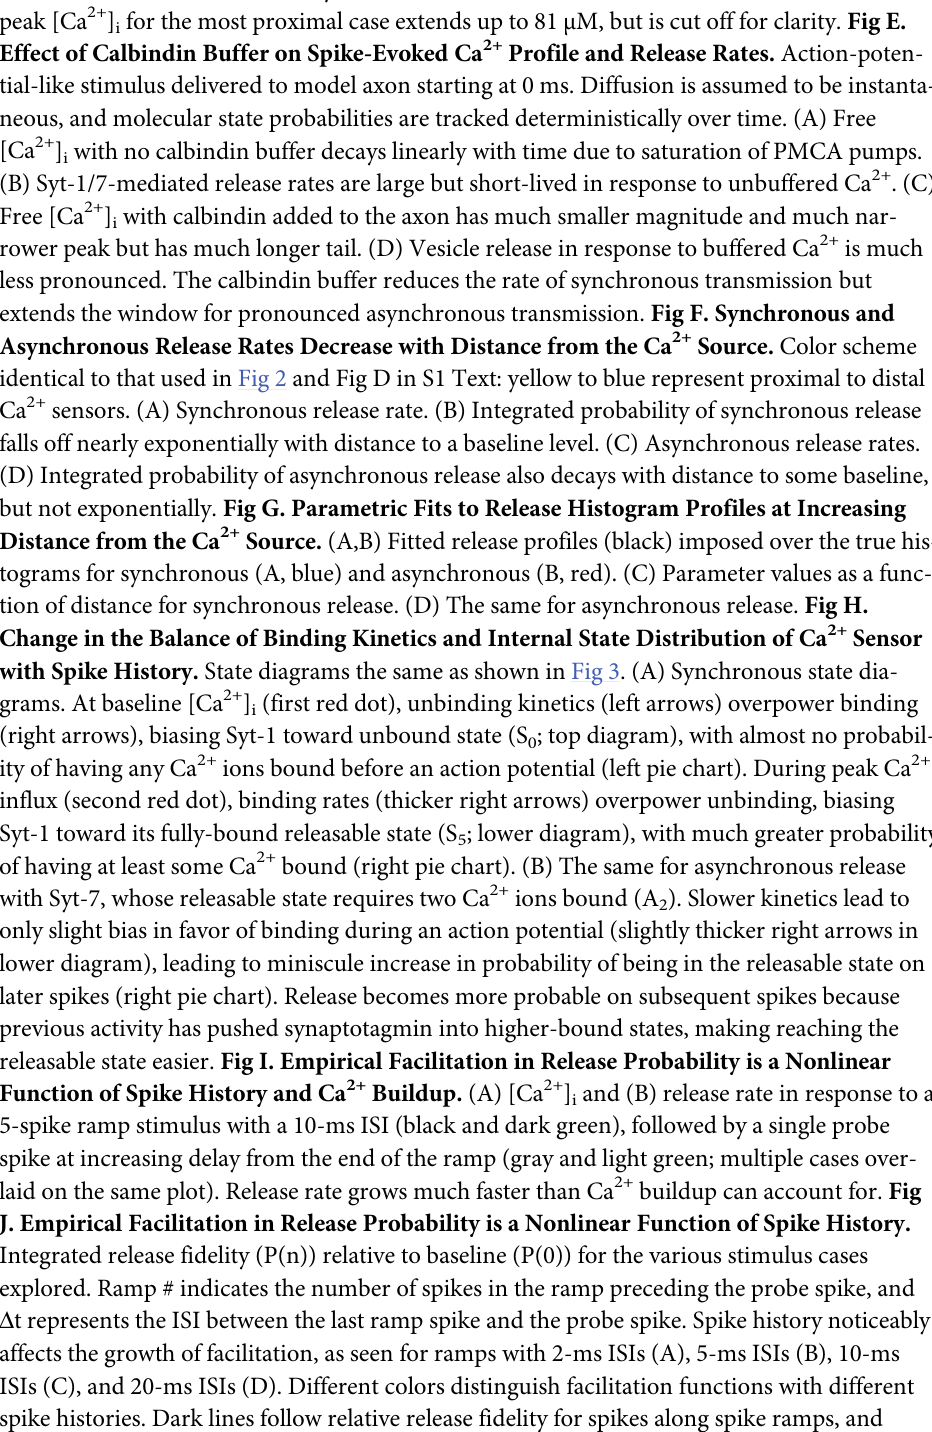
that used in Fig 2: yellow to blue represent proximal to distal Ca 2+ sensors. (A) [Ca 2+ ] mea- i sured at increasing distance from VDCC source (yellow to blue), with well-mixed approxima- tion overlaid for comparison (maroon). Inset focuses on shorter time scale. (B) Profiles with calbindin removed from MCell (yellow to blue) and well-mixed model (maroon). Note that peak [Ca 2+ ] for the most proximal case extends up to 81 μ M, but is cut off for clarity. Fig E. i Effect of Calbindin Buffer on Spike-Evoked Ca 2+ Profile and Release Rates. Action-poten- tial-like stimulus delivered to model axon starting at 0 ms. Diffusion is assumed to be instanta- neous, and molecular state probabilities are tracked deterministically over time. (A) Free [Ca 2+ ] with no calbindin buffer decays linearly with time due to saturation of PMCA pumps. i (B) Syt-1/7-mediated release rates are large but short-lived in response to unbuffered Ca 2+ . (C) Free [Ca 2+ ] with calbindin added to the axon has much smaller magnitude and much nar- i rower peak but has much longer tail. (D) Vesicle release in response to buffered Ca 2+ is much less pronounced. The calbindin buffer reduces the rate of synchronous transmission but extends the window for pronounced asynchronous transmission. Fig F. Synchronous and Asynchronous Release Rates Decrease with Distance from the Ca 2+ Source. Color scheme identical to that used in Fig 2 and Fig D in S1 Text: yellow to blue represent proximal to distal Ca 2+ sensors. (A) Synchronous release rate. (B) Integrated probability of synchronous release falls off nearly exponentially with distance to a baseline level. (C) Asynchronous release rates. (D) Integrated probability of asynchronous release also decays with distance to some baseline, but not exponentially. Fig G. Parametric Fits to Release Histogram Profiles at Increasing Distance from the Ca 2+ Source. (A,B) Fitted release profiles (black) imposed over the true his- tograms for synchronous (A, blue) and asynchronous (B, red). (C) Parameter values as a func- tion of distance for synchronous release. (D) The same for asynchronous release. Fig H. Change in the Balance of Binding Kinetics and Internal State Distribution of Ca 2+ Sensor with Spike History. State diagrams the same as shown in Fig 3. (A) Synchronous state dia- grams. At baseline [Ca 2+ ] (first red dot), unbinding kinetics (left arrows) overpower binding i (right arrows), biasing Syt-1 toward unbound state (S ; top diagram), with almost no probabil- 0 ity of having any Ca 2+ ions bound before an action potential (left pie chart). During peak Ca 2+ influx (second red dot), binding rates (thicker right arrows) overpower unbinding, biasing Syt-1 toward its fully-bound releasable state (S ; lower diagram), with much greater probability 5 of having at least some Ca 2+ bound (right pie chart). (B) The same for asynchronous release with Syt-7, whose releasable state requires two Ca 2+ ions bound (A ). Slower kinetics lead to 2 only slight bias in favor of binding during an action potential (slightly thicker right arrows in lower diagram), leading to miniscule increase in probability of being in the releasable state on later spikes (right pie chart). Release becomes more probable on subsequent spikes because previous activity has pushed synaptotagmin into higher-bound states, making reaching the releasable state easier. Fig I. Empirical Facilitation in Release Probability is a Nonlinear Function of Spike History and Ca 2+ Buildup. (A) [Ca 2+ ] and (B) release rate in response to a i 5-spike ramp stimulus with a 10-ms ISI (black and dark green), followed by a single probe spike at increasing delay from the end of the ramp (gray and light green; multiple cases over- laid on the same plot). Release rate grows much faster than Ca 2+ buildup can account for. Fig J. Empirical Facilitation in Release Probability is a Nonlinear Function of Spike History. Integrated release fidelity (P(n)) relative to baseline (P(0)) for the various stimulus cases explored. Ramp # indicates the number of spikes in the ramp preceding the probe spike, and Δ t represents the ISI between the last ramp spike and the probe spike. Spike history noticeably affects the growth of facilitation, as seen for ramps with 2-ms ISIs (A), 5-ms ISIs (B), 10-ms ISIs (C), and 20-ms ISIs (D). Different colors distinguish facilitation functions with different spike histories. Dark lines follow relative release fidelity for spikes along spike ramps,